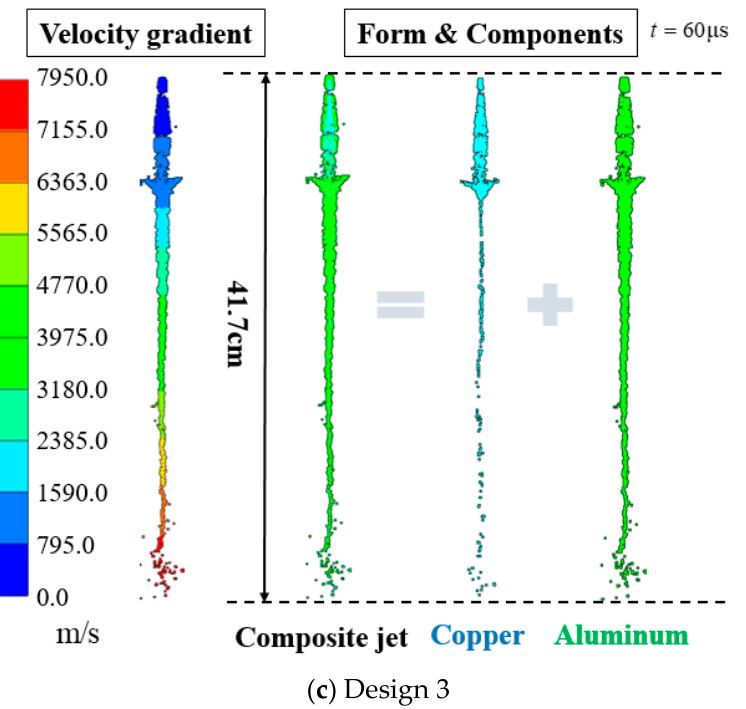
Figure 14. The velocity gradient and distribution of jets in design 1~3 ( a – c ).